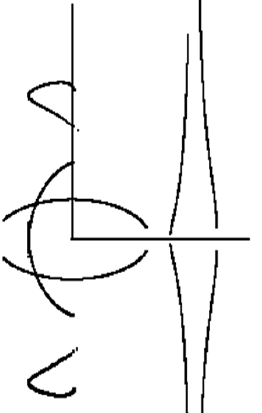
Figure 14. q = 0.5, KG = 100, and DK = 140.